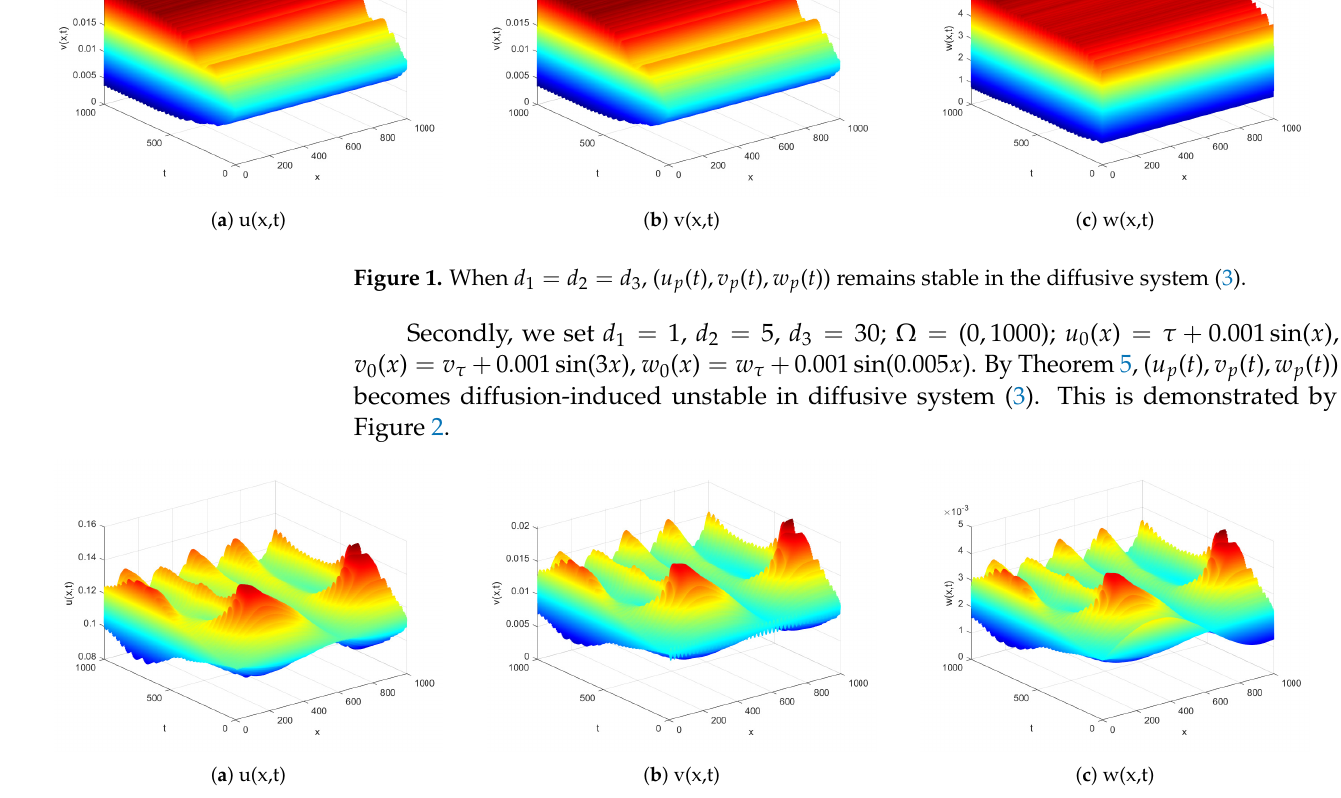
Figure 2. ( u p ( t ), v p ( t ), w p ( t )) becomes diffusion-induced unstable, and the emerging spatiotemporal patterns can be